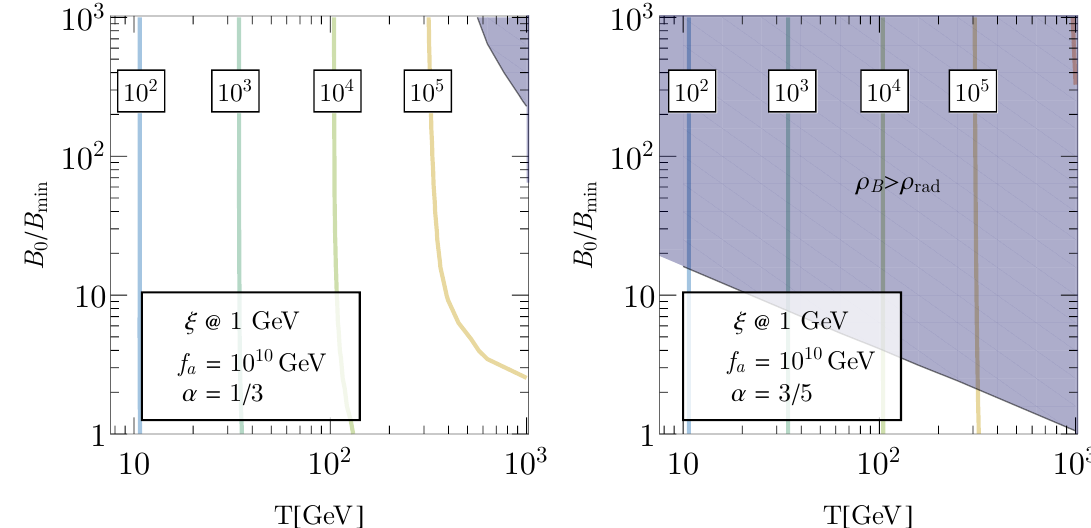
Figure 5 . ξ at T = 1 GeV as a function of T init and B 0 today, scaled by the observed lower bound B min ≡ 1 · 10 − 13 G. The contours are labelled by the value of ξ at T = 1 GeV. f a is taken to be 10 10 GeV. Left : α = 1 / 3 , Right : α = 3 / 5 .